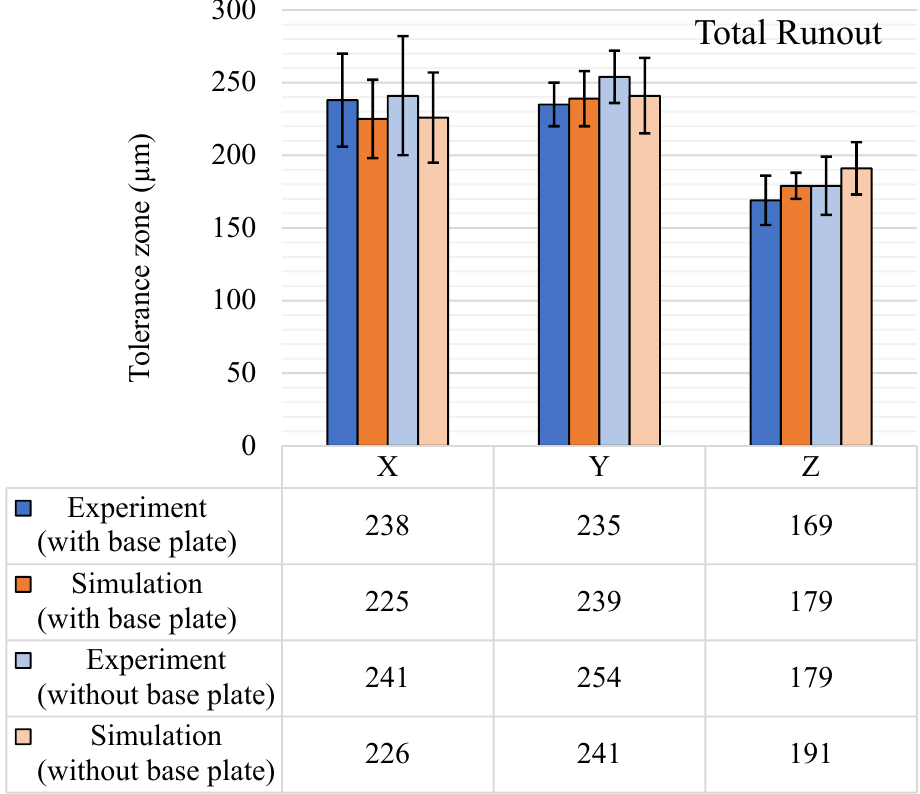
Figure 20. Total runout (µm) tolerance results, with and without the base plate.